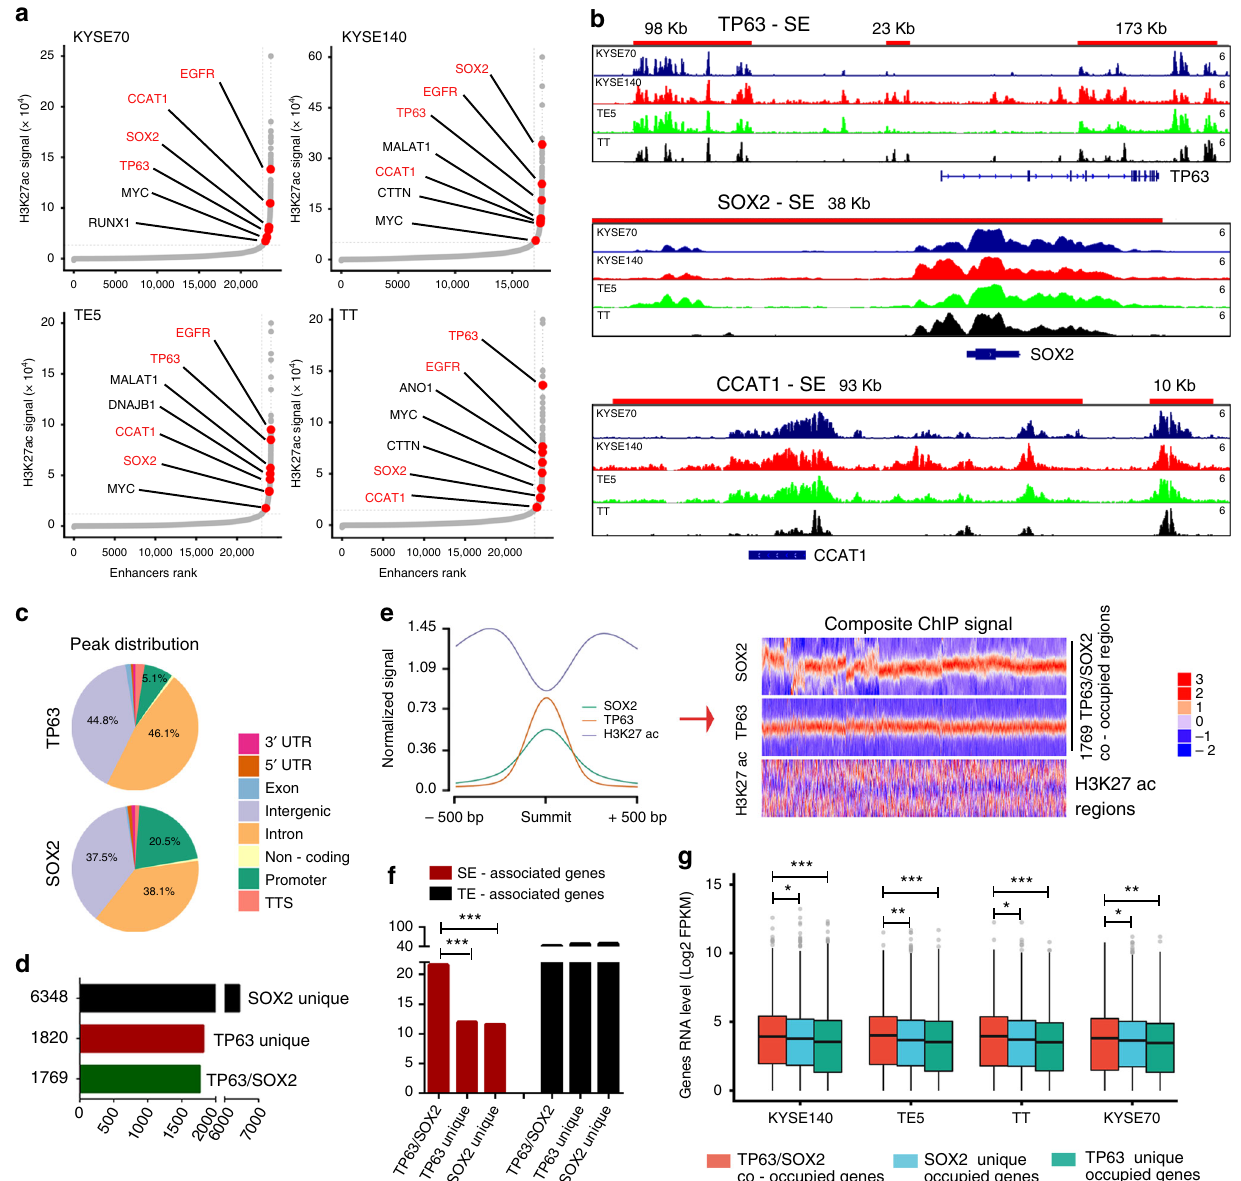
Fig. 1 Super-enhancers are associated with TP63 and SOX2 in SCCs. a Hockey stick plots on the basis of their input-normalized H3K27ac signals in KYSE70, KYSE140, TE5, and TT cell lines. Know super-enhancer-associated oncogenes are highlighted. b Gene tracks of H3K27ac ChIP-seq occupancy at representative super-enhancer-associated gene loci in four cell lines. X axis shows genomic position and Y axis shows signal of ChIP-seq occupancy in units of reads per million mapped reads per base pair (rpm/bp). c Genome-wide distribution of TP63 and SOX2 ChIP-seq peaks in TE5 cells. d The number of TP63 unique, SOX2 unique and TP63/SOX2 co-occupied genomic loci in TE5 cells. e Left: line plots showing ChIP-seq signals of TP63, SOX2 and H3K27ac centered at the summit of TP63 and SOX2 peaks in TE5 cells. Right: heatmap of ChIP-seq signals for TP63, SOX2, and H3K27ac (±500 bp windows around the center of summit) rank ordered by TP63 signal. Red re fl ects enrichment. f Proportion of super-enhancer (SE)-associated genes (red) and typical- enhancer (TE)-associated genes (black) either uniquely bound or co-bound by TP63 and SOX2. g mRNA level of super-enhancer-associated genes either uniquely bound or co-bound by TP63 and SOX2. Red, blue, and green box plot represents the expression levels of TP63/SOX2 co-occupied genes, TP63 uniquely occupied genes and SOX2 uniquely occupied genes,